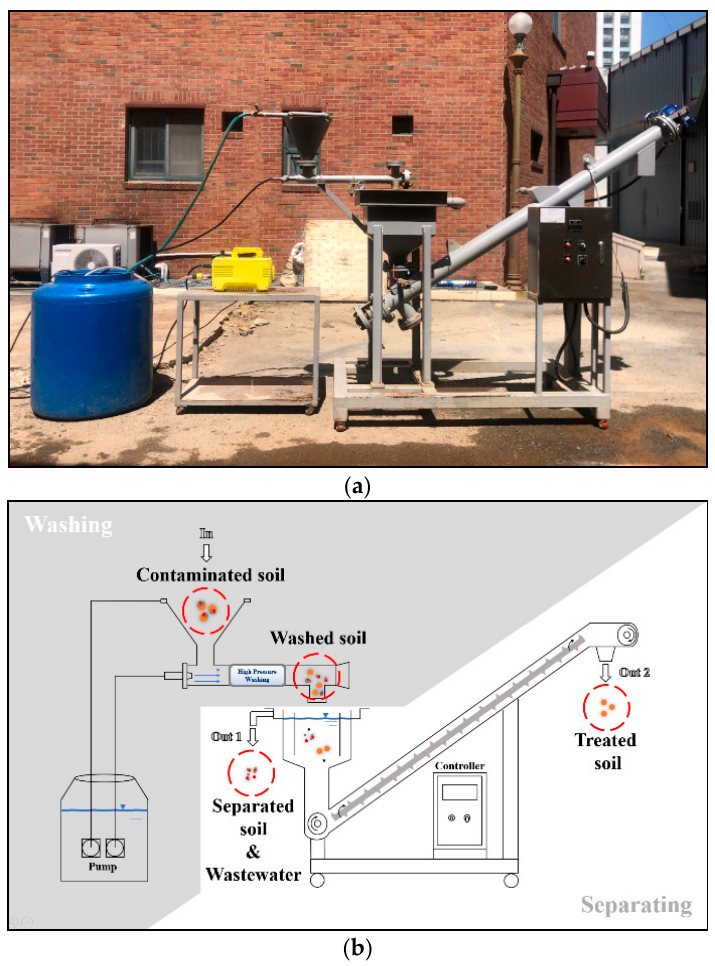
Figure 1. ( a ) High-pressure washing machine (0.6 ton/h); and ( b ) schematic diagram of high-pressure washing